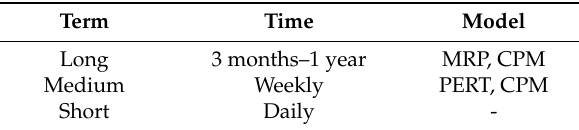
Table 1. Maintenance scheduling